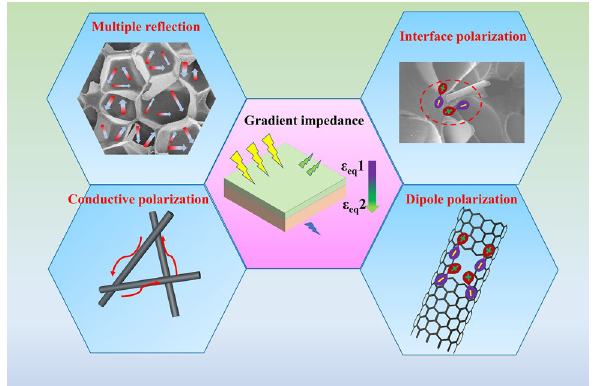
Fig. 5 Schematic diagram of the absorbing mechanism of CP com-